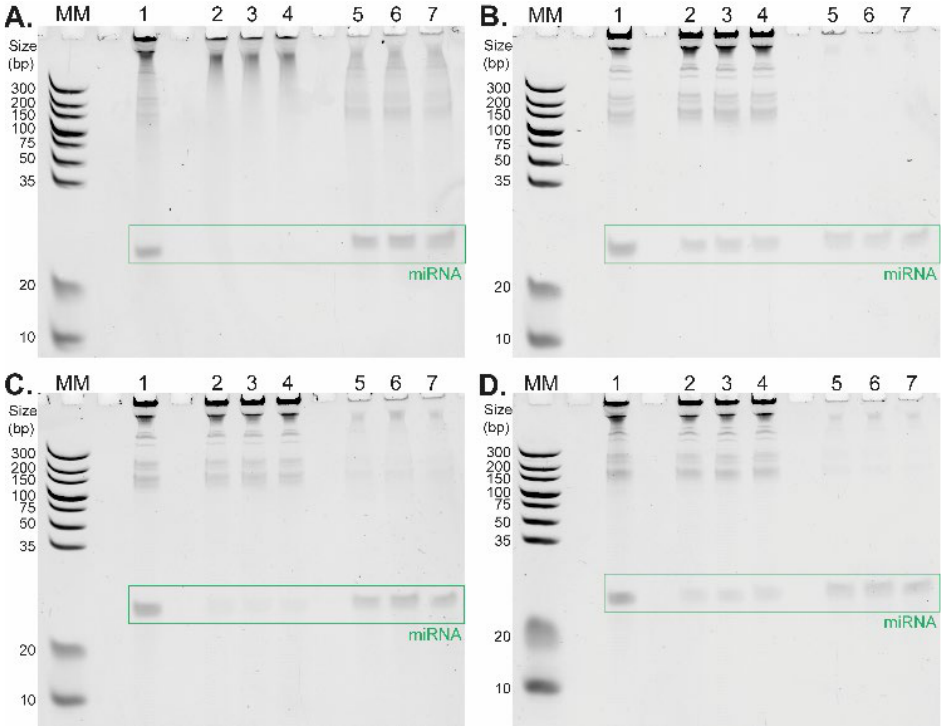
Figure 2. Urea-PAGE analysis of short RNA isolation (triplicate) from a model mixture (Jurkat cells genomic RNA + hsa-miR-18a-3p) in different binding conditions, followed by SYBR Green II staining. Binding conditions: ( A ) glycine/HCl buffer (pH 2.4), ( B ) MES buffer with 5 mM citric acid (pH 4), ( C ) acetate buffer (pH 4.4), and ( D ) acetate buffer with 5 mM citric acid (pH 4.4). Lanes: MM—marker of nucleotide sizes (Ultra Low Range DNA Ladder, 10 bp to 300 bp); 1—initial model mixture of RNA; 2, 3, 4—supernatant fractions; 5, 6, 7—elution fractions.